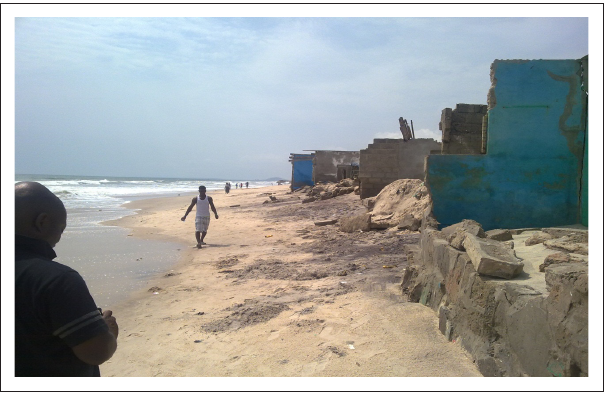
Source : Picture taken by Kwasi Appeaning Addo FIGURE 3: Collapsing buildings along the beach at Gleefe.